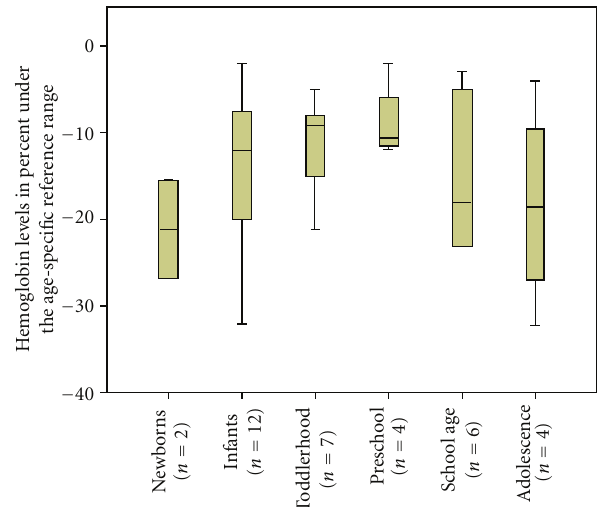
Figure 1: Hemoglobin levels of the analyzed age groups. Boxplots represent median and interquartiles. The whiskers extend to 1.5 times the di ff erence between the first and third quartiles.